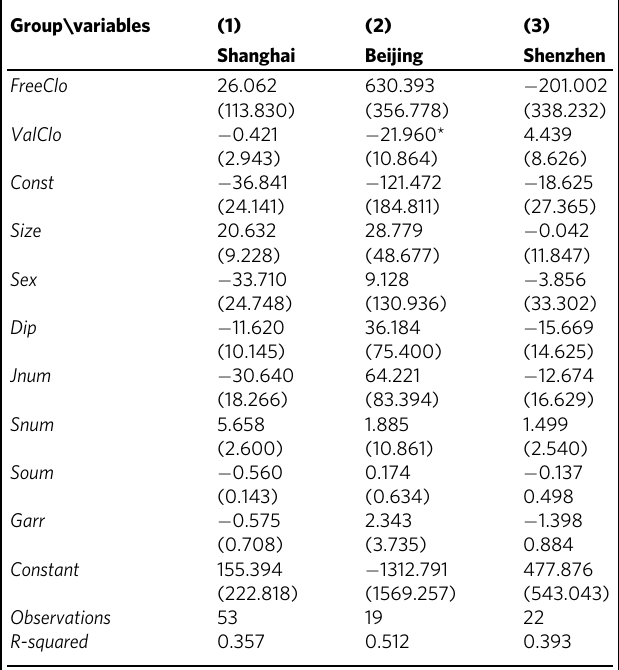
Table 8 Regression results from a region heterogeneity